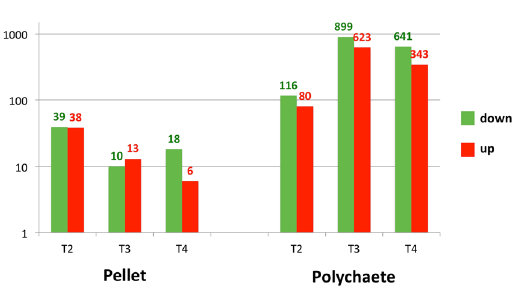
Figure 3. Numbers of DEGs after eyestalk ablation of the pellet-fed shrimp and the polychaete-fed shrimp at Day 1, 4, and 9 (T2, T3, and T4, respectively). Red and green bars indicate up- and downregulated DEGs. A base-10 log scale is used for the Y